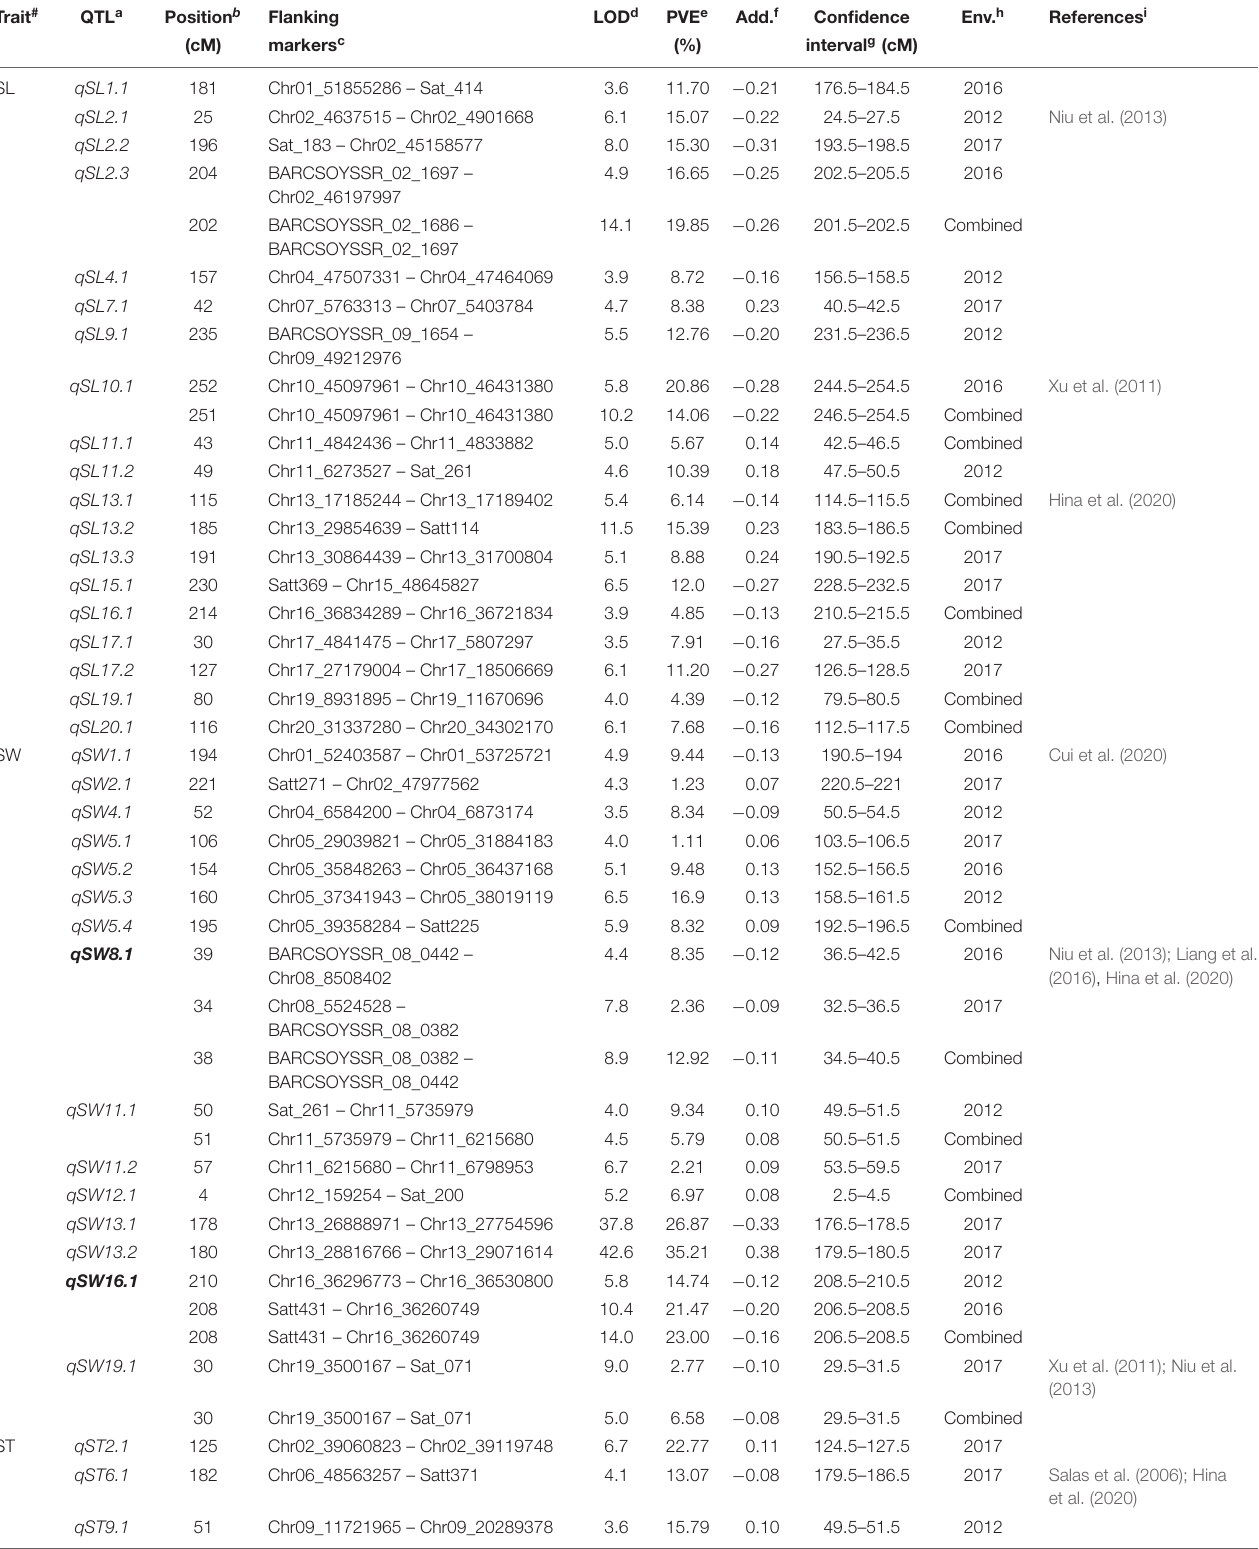
TABLE 1 | QTLs identified for seed-size traits in K099 × Fendou 16 RIL population across multiple